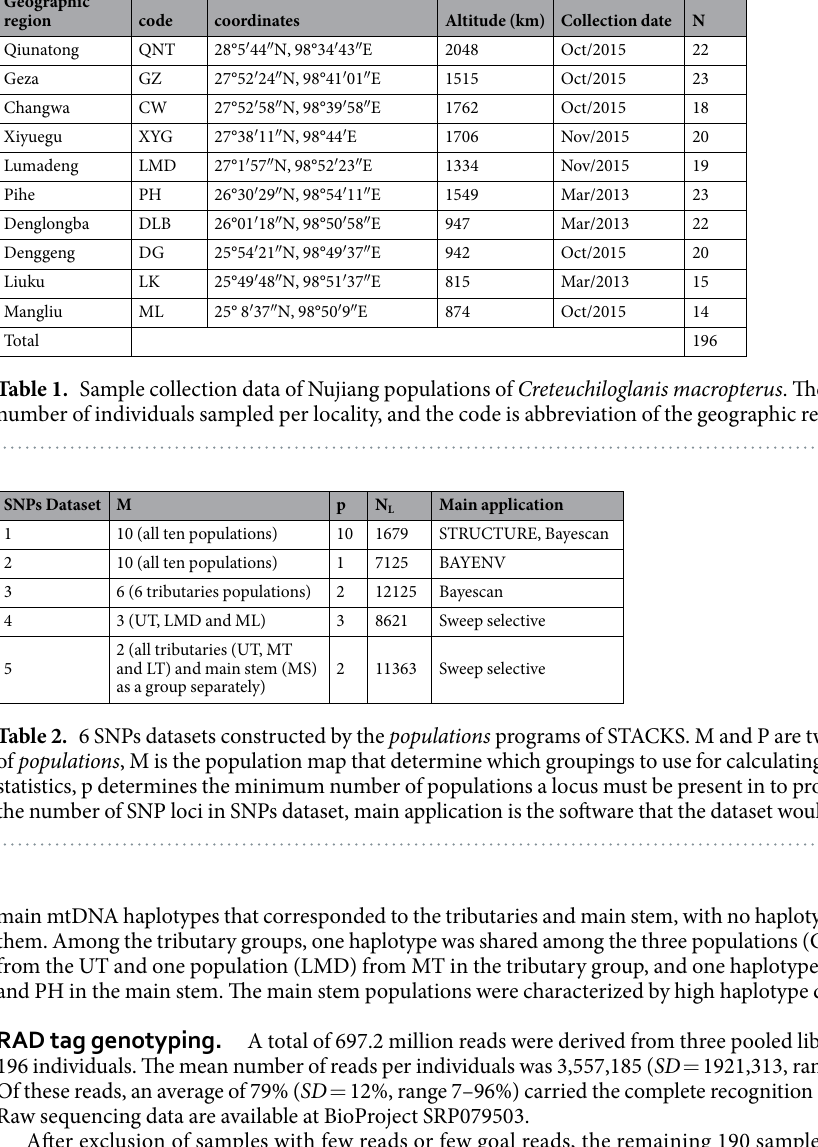
3 SCIenTIfIC REPORTS | 7: 2813 | DOI:10.1038/s41598-017-02853-3